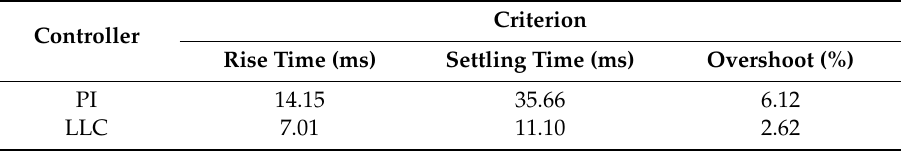
Table 5. Comparison of the Step Response for the Bidirectional